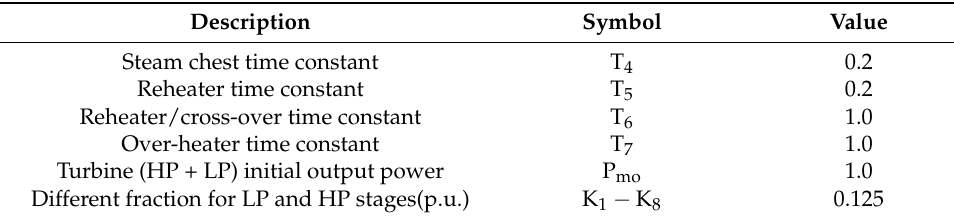
Table 3. Steam turbine parameters used in the microgrid.